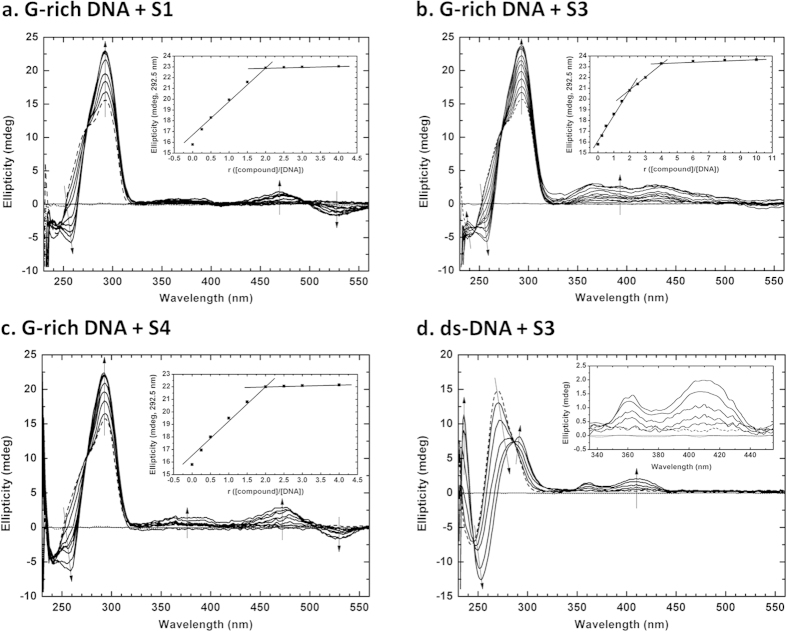
CD spectra for the interaction between benzothioxanthene derivatives S1, S3, S4 and 26 nt telomeric G-rich DNA sequences of human chromosome in 10 mM K+ by titration of S1, S3 and S4 into DNA.All experiments were performed in a buffer (pH 7.4) containing 10 mM Tris–HCl, 10 mM KCl, 0.1 mM EDTA, and samples of 4 μM G-rich DNA (in single strand) and 2 μM double-stranded DNA (in double strand) dissolved in the buffer were incubated for 24 h after annealing at 95 °C. (a) The CD spectrum for G-rich-DNA in the presence/absence of S1 at the ratio of S1 to DNA (r), 0.0, 0.25, 0.5, 1.0, 1.5, 2.0, 2.5, 3.0, 3.5, 4.0, of which the inset is the change of CD with the r ([compounnd]/[DNA]) at 292.5 nm. (b) The CD spectrum for G-rich-DNA in the presence/absence of S3 at the ratio of S3 to DNA (r), 0.0, 0.25, 0.5, 1.0, 1.5, 2.0, 2.5, 3.0, 4.0, 6.0, 8.0, 10, of which the inset is the change of CD with the r at 292.5 nm. (c) The CD spectrum for G-rich-DNA in the presence/absence of S4 at the ratio of S4 to DNA (r), 0.0, 0.25, 0.5, 1.0, 1.5, 2.0, 2.5, 3.0, 3.5, 4.0, of which the inset is the change of CD with the r at 292.5 nm. (d) The CD spectrum for ds-DNA in the presence/absence of S3 at the ratio of S3 to DNA (r), 0.0, 1.0, 2.0, 4.0, 8.0, 16, of which the inset is the enlarged view of ICD in the range from 355 to 455 nm. Arrows denote the increase of the compound concentration. Dashed line: DNA alone; dotted line: compound alone.